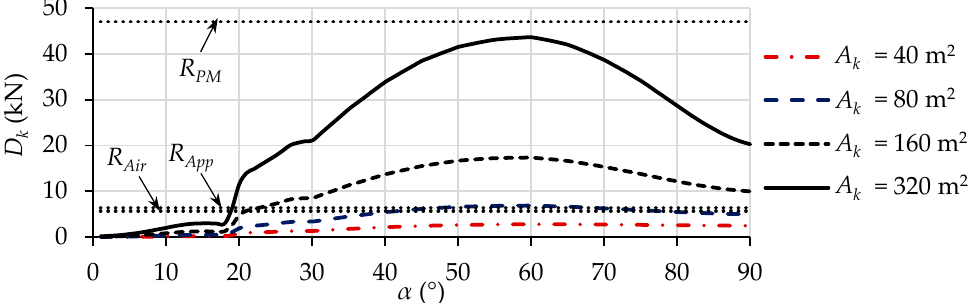
Figure 10. The kite thrust forces compared to the air resistance, appendage resistance and power margin of the Series 60 ship at a ship speed of 7.27 m/s and a reference wind speed of 20 m/s.